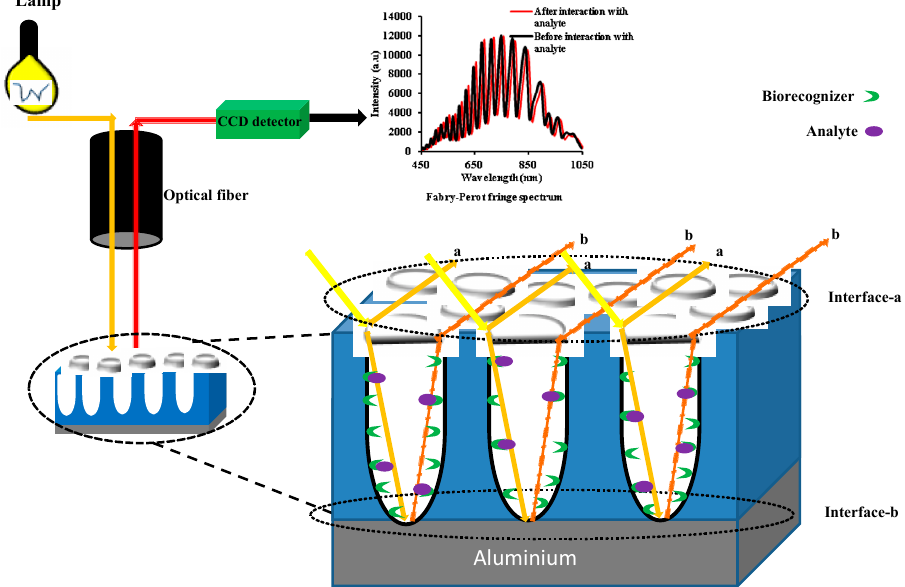
Figure 1. Schematic representation of the interferometric reflectance spectroscopy (IRS) detection Figure1. system.